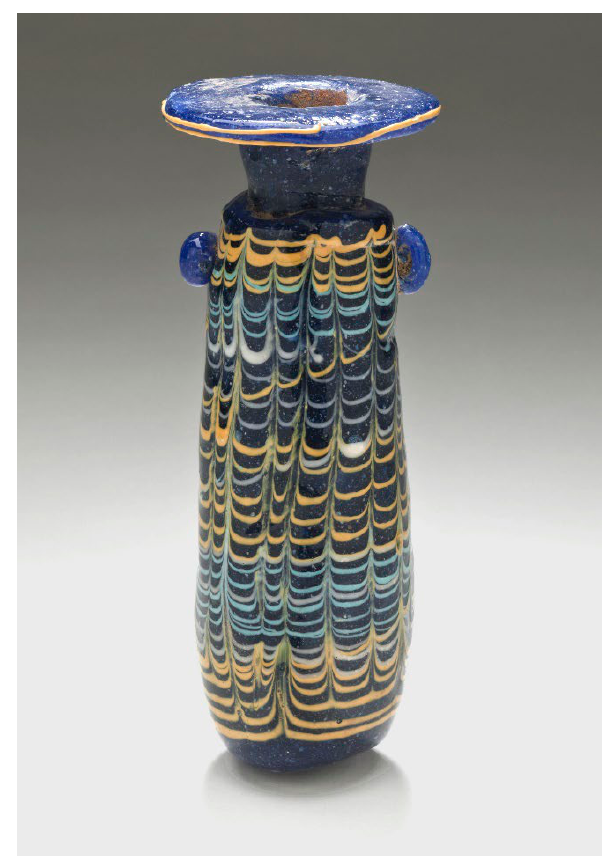
Figure 4. Core-formed glass Alabastron (6th - 4th century BCE) [M.88.129.10; Courtesy of the Los Angeles County Museum of Art].